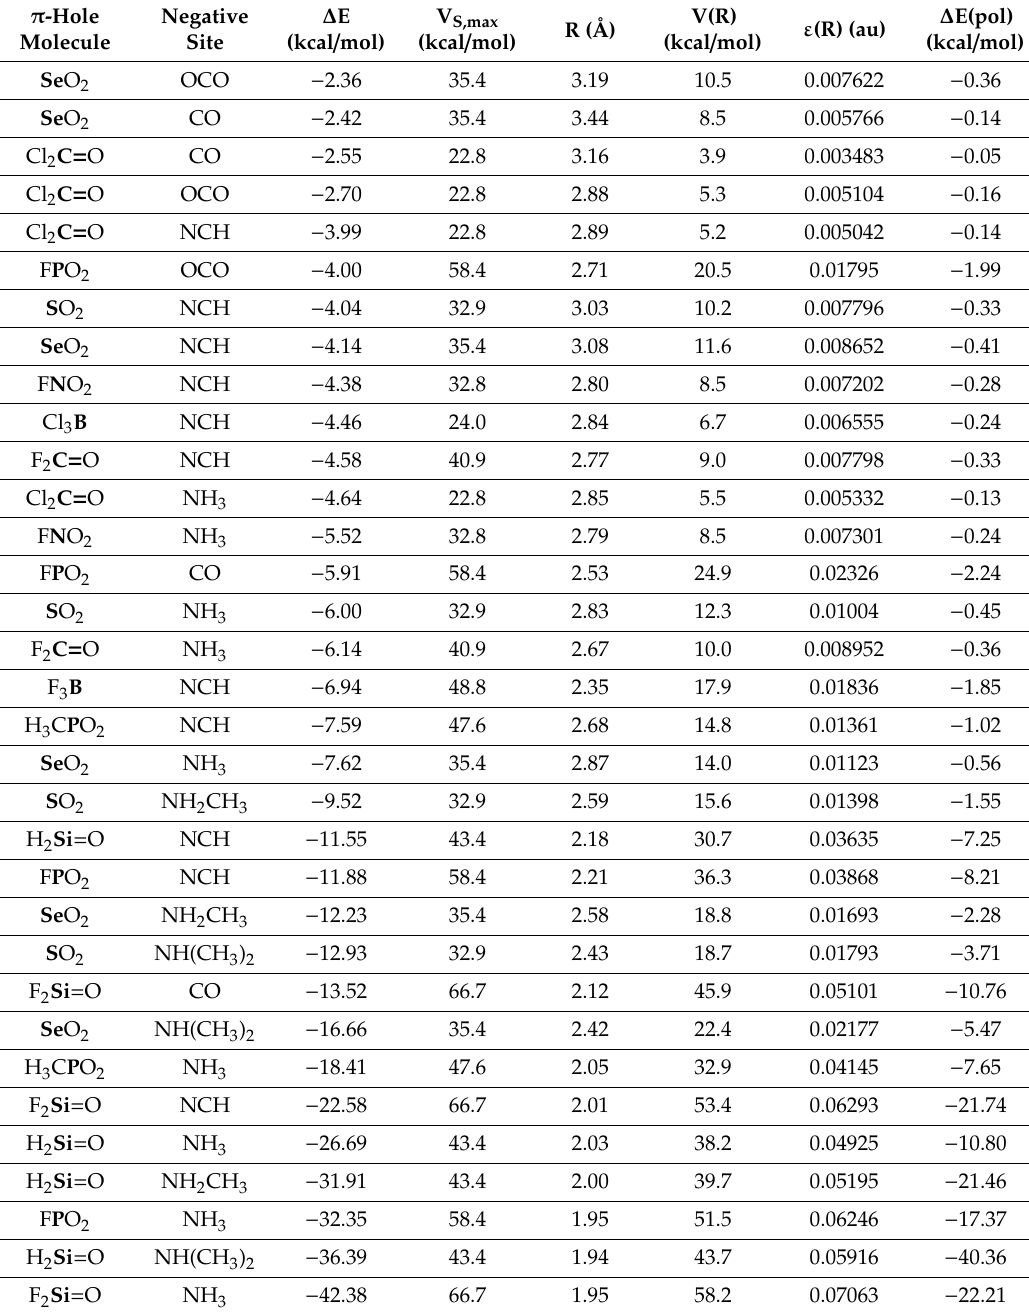
Table 2. Computed data for π -hole interactions. Atoms with π -holes are indicated in bold . Interactions are with the first atom listed for the negative site. ∆ E is interaction energy, as shown in Equation (2). V S,max is the most positive electrostatic potential of the π -hole on the 0.001 au molecular surface before interaction. R is the equilibrium interaction separation. V(R) and ε (R) are the electrostatic potential and electric field of the π -hole molecule at the approximate position of the negative site. ∆ E(pol) is the energy of polarization of the negative site, as shown in Equation